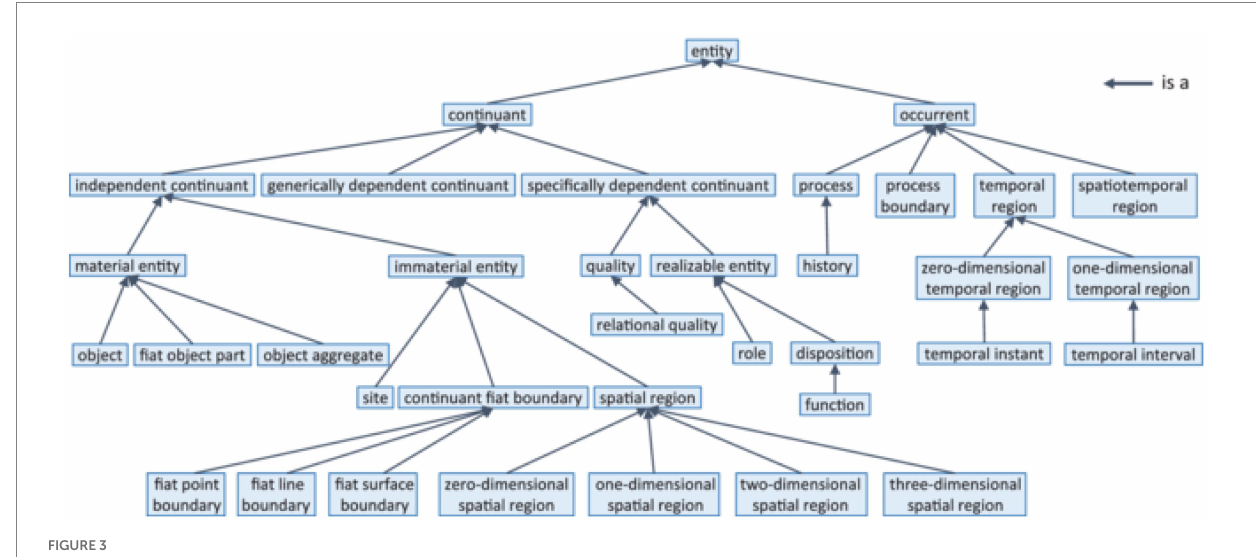
FIGURE 3 BFO-2020 taxonomy (according to ISO 21838-2